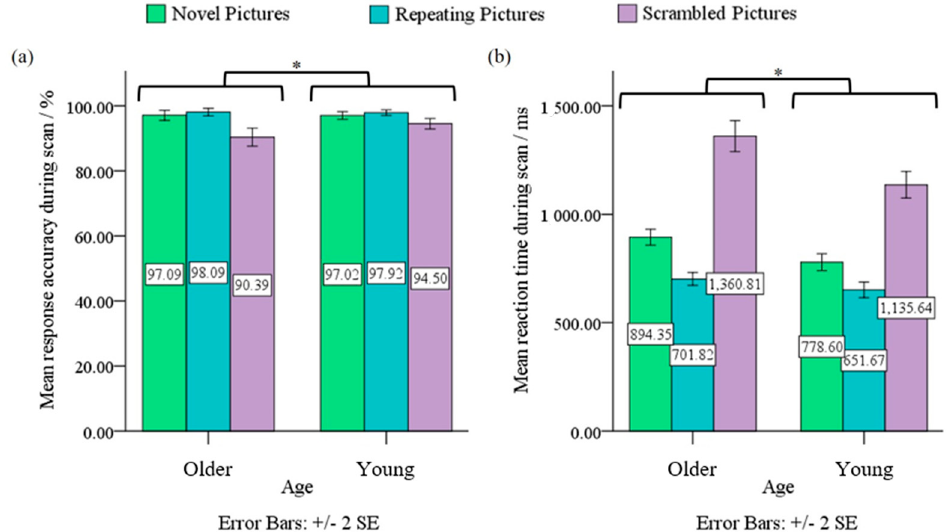
Figure 2. ( a ) Age × condition mixed design ANOVA on ACC revealed a signi fi cant interaction e ff ect and a main e ff ect of condition, at p < 0.05. ( b ) Age × condition mixed design ANOVA on RT revealed signi fi cant interaction e ff ect, main e ff ects of age and condition, at p < 0.05 *. A similar 2 × 3 ANOVA on RT showed signi fi cant age × condition interaction e ff ect,